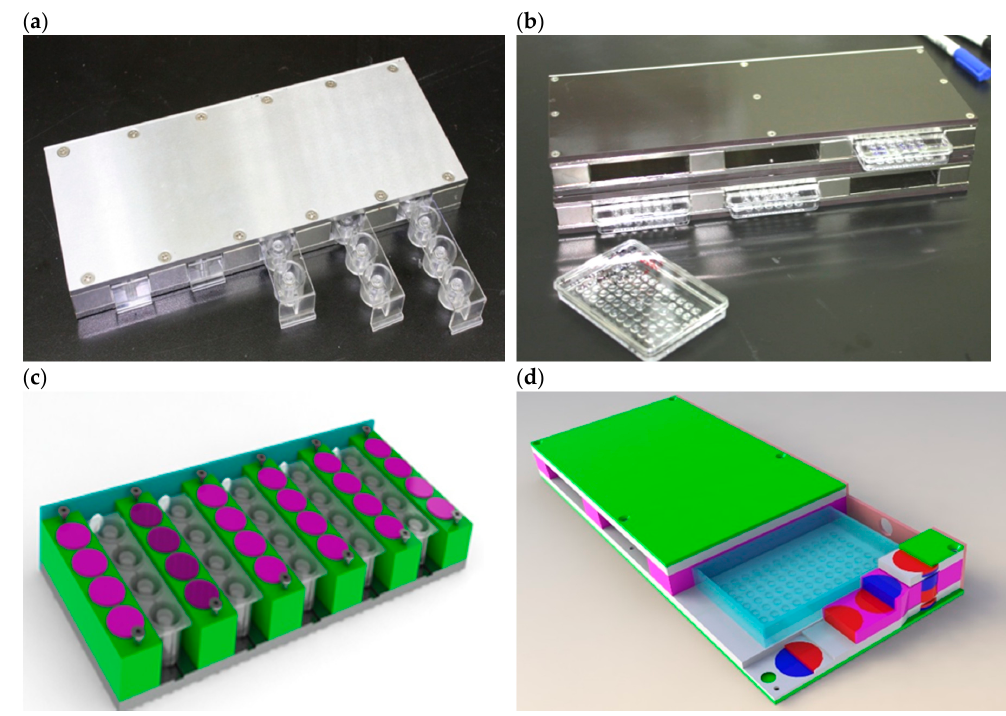
Figure 1. Devices designed previously consisting of a simple cassette with round magnets compactly packed into an aluminum frame and covered by carbon steel and aluminum plates. ( a ) Disassembled and assembled positions of the device with a 24-well plate. ( b ) Disassembled and assembled positions of the device with 72-wells. ( c ) Schematic diagram of the direction of the magnetic field for the 24-well device. ( d ) Schematic diagram of the direction of the magnetic field for the 72-well